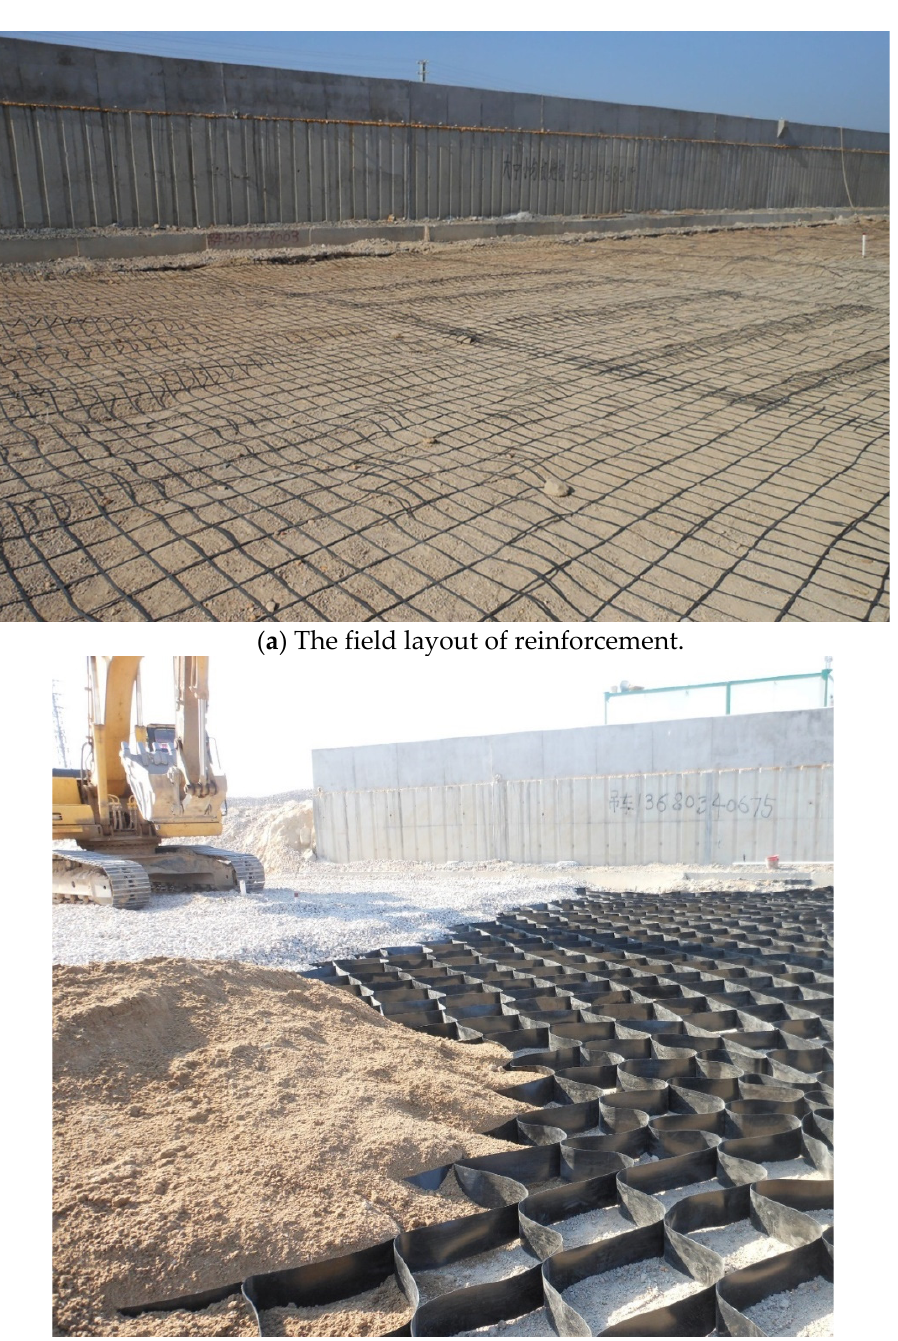
Figure 7. Site layout of GR: ( a ) geogrid layout; ( b ) site layout. (2) Field test